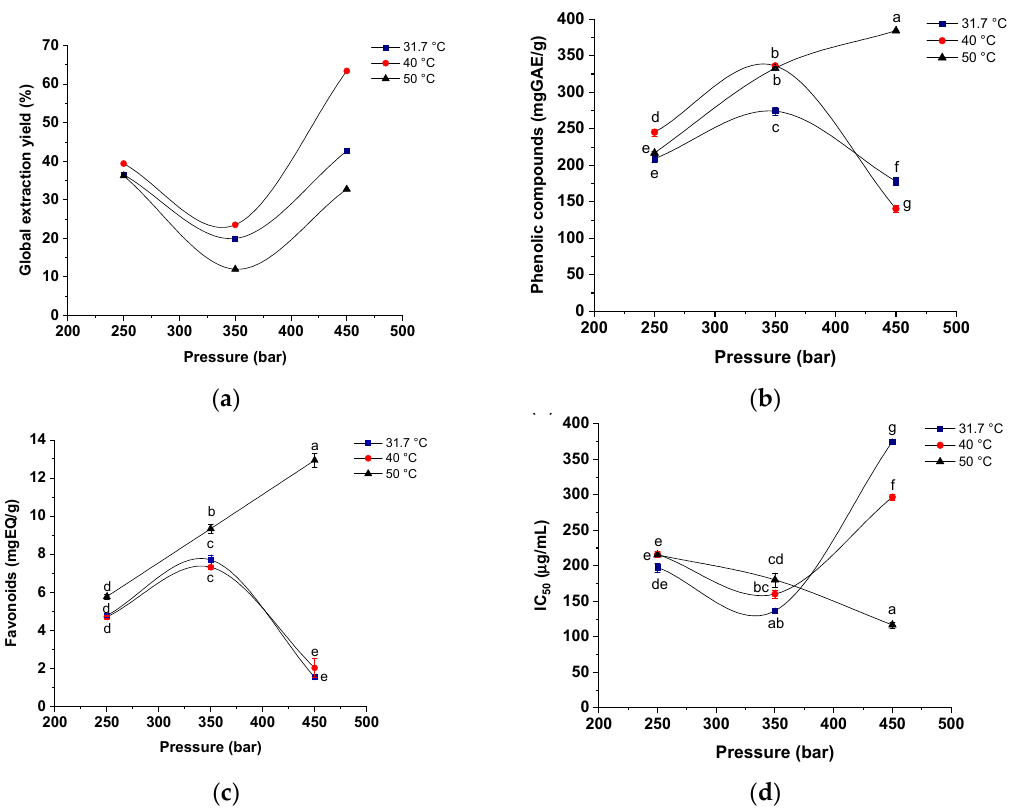
Figure 4. Global yield isotherms for ( a ) total yield percentage (%); ( b ) content of total phenolic compounds (mg EGA/g); ( c ) content of total flavonoids (mg EGA/g); and ( d ) antioxidant activity (IC50) ( μ g/mL) for the red propolis extracts using CO 2 as supercritical fluid, ethanol as cosolvent (4% w/w ) at temperatures of 31.7, 40 and 50 °C and pressures of 250, 350 and 450 bar (CO 2 flow rate of 6 g/min and S/F of 131). Points with the same letter are not significantly different ( p < 0.05) according to Tukey’s test at the 95% confidence level.